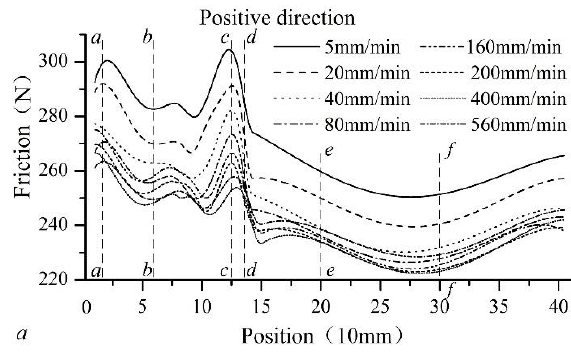
Figure 11. IAFV curves and associated MVOIAF for three tests at a feed velocity of 5 mm/min. ( a ) Position direction; ( b ) Negative direction.